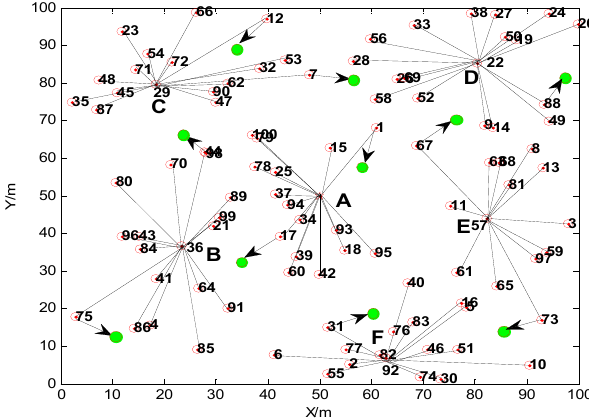
Figure 5. The original random deployment of the nodes.